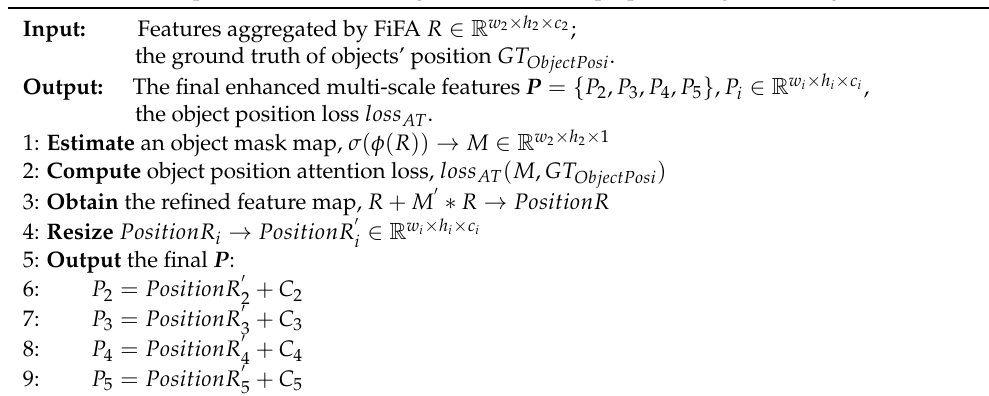
Algorithm 2 The pseudo-code for refining features with the proposed Target-Focusing Block